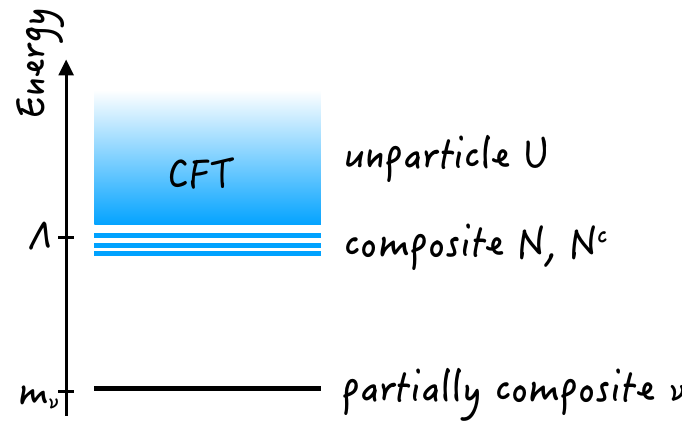
Figure 2 . A sketch of the spectrum of particle masses in our framework, showing the light partially composite neutrinos and the composite resonances at the compositeness scale Λ that blend into a continuum of “unparticles” at higher